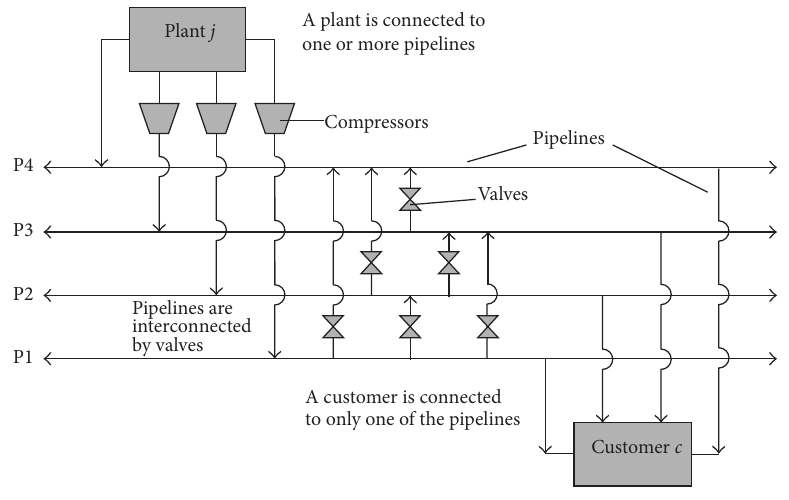
Figure 1: Network of plants, pipelines, and customers from